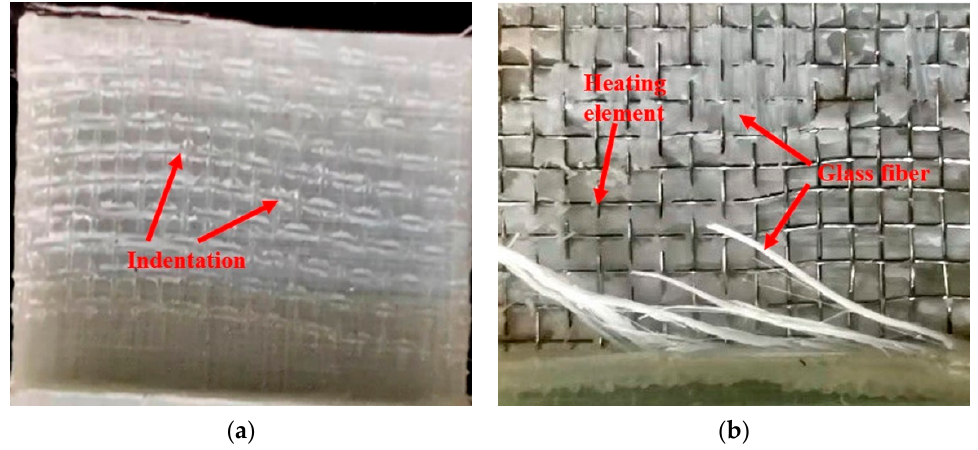
Figure 10. Macro appearance of lap joints: ( a ) Current 10.5 A, pressure 1 MPa, and time 180 s; ( b ) Current 12.5 A, pressure 2.5 MPa, and time 540 s.